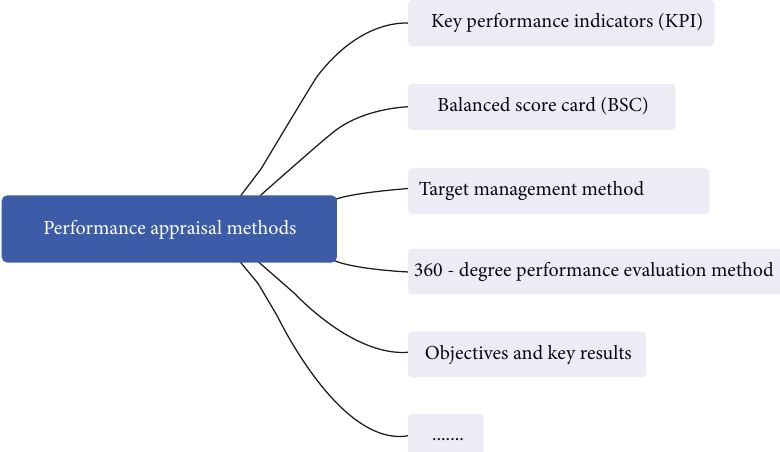
Figure 2: Main methods of performance